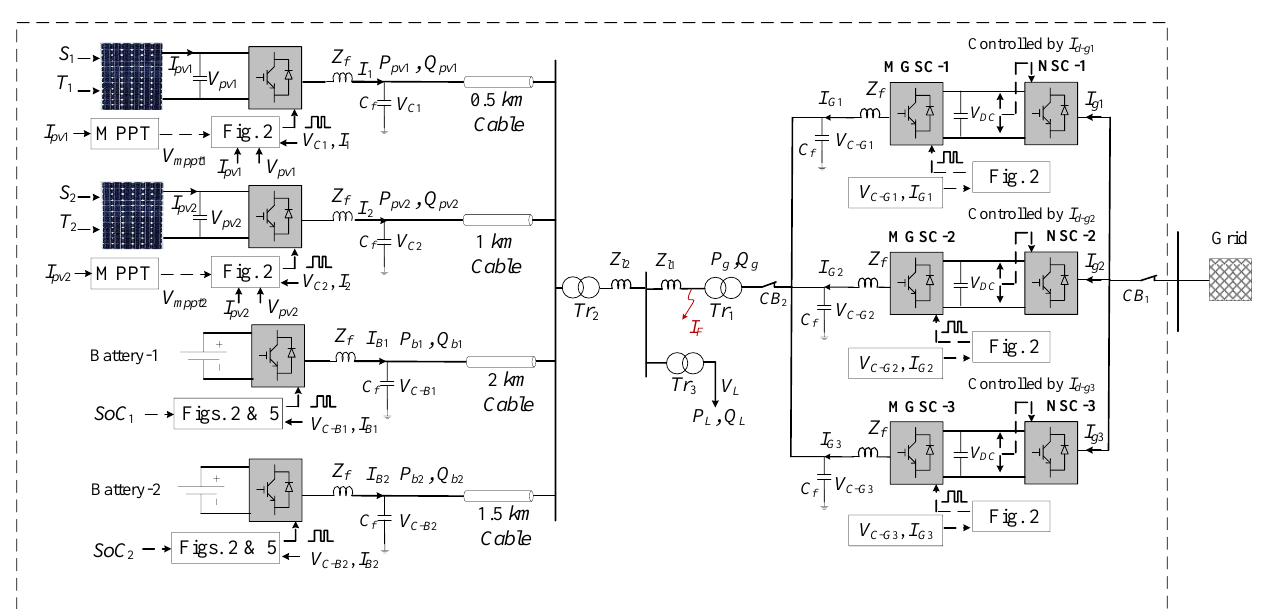
Figure 1. Microgrid system under study with proposed modular back-to-back converter interface.